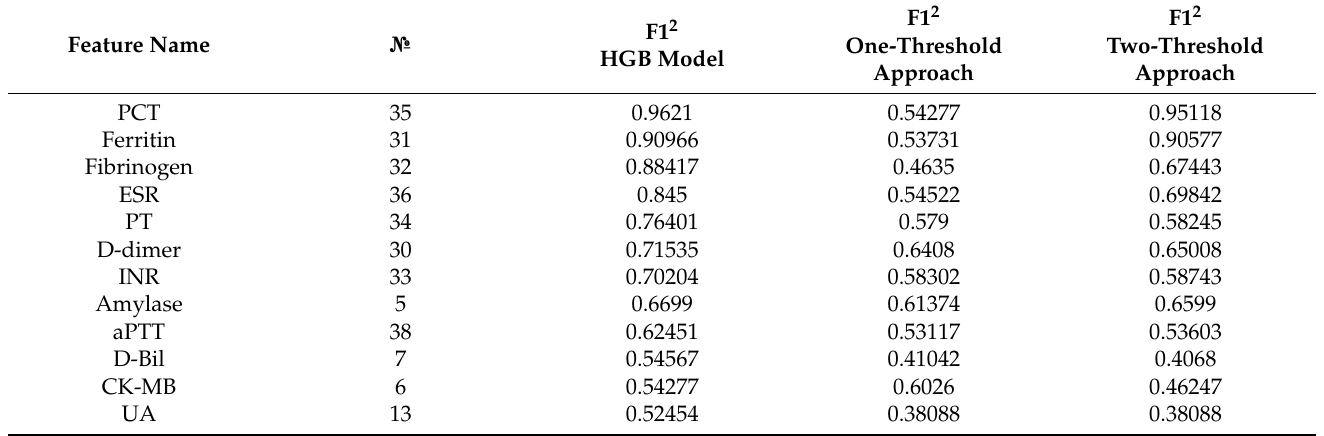
Table 5. List of the 12 most significant single features for classification using the HGB algorithm, with F1 2